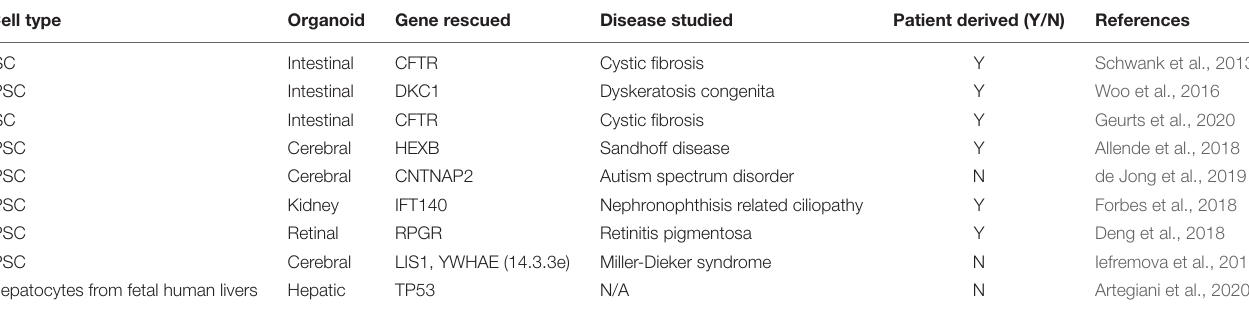
TABLE 2 | CRISPR Cas9 examples to rescue